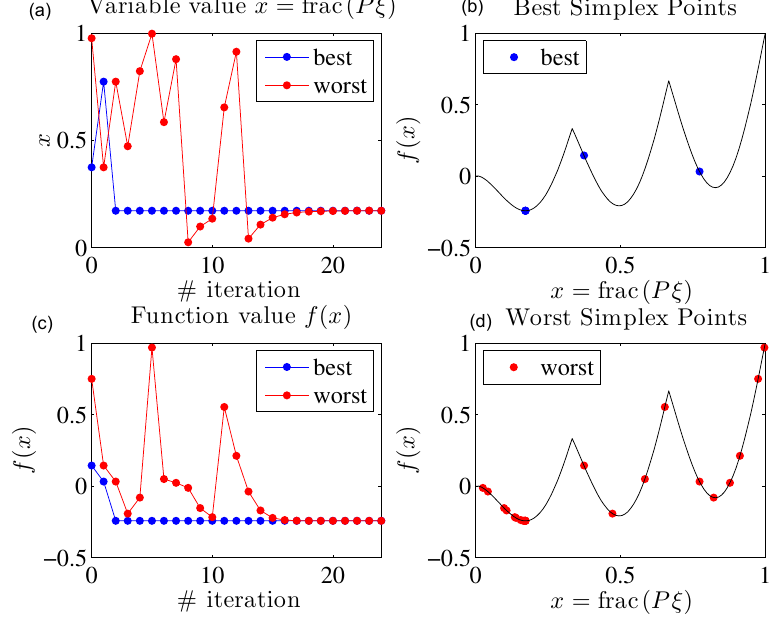
Figure 3. The parameters of the algorithm are P = 10 4 , σ = 0.5, ρ = 1.05, c = 0.01, (cid:101) = 10 − 4 / P